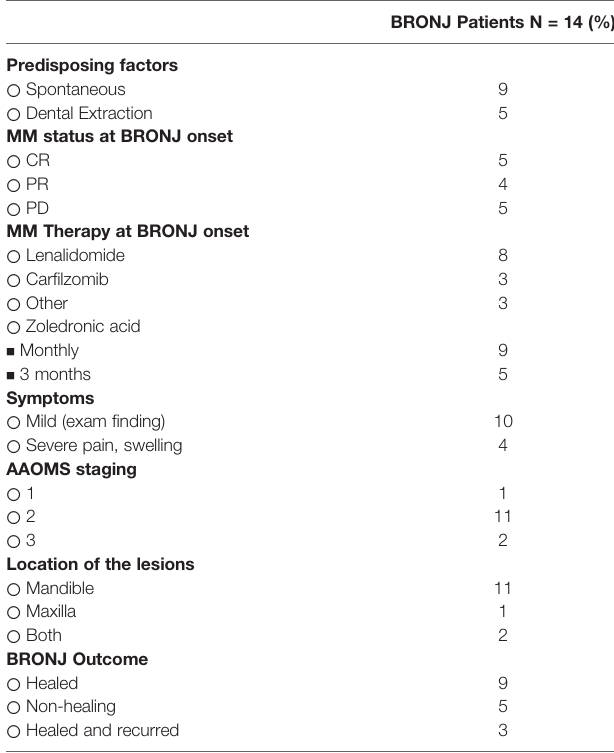
TABLE 2 | Characteristics and outcome of BRONJ